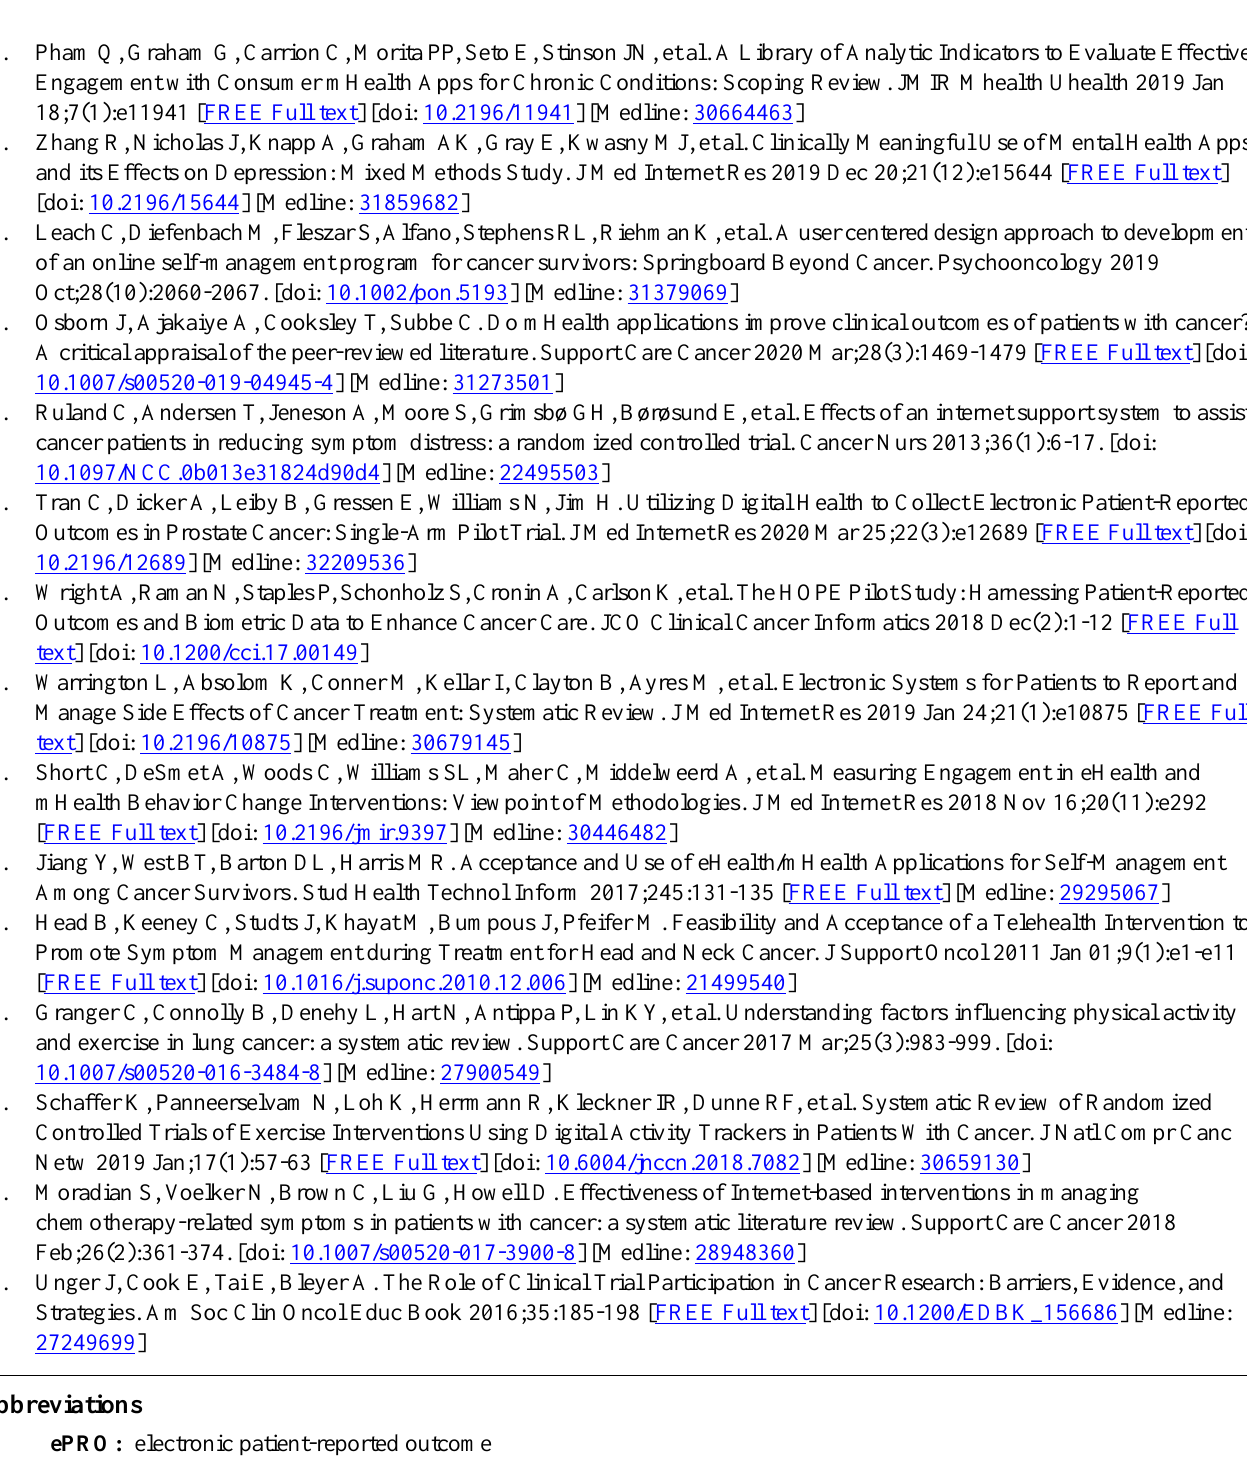
Abbreviations ePRO: electronic patient-reported outcome HNC: head and neck cancer mHealth: mobile health PRO: patient-reported outcome REDCap: Research Electronic Data Capture SUS: system usability